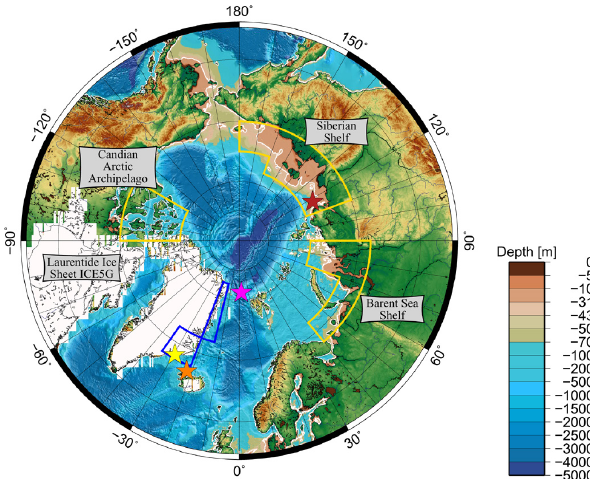
Fig. 1. Topographic map showing modern day bathymetry (National Geophysical Data Center, 2001) in the Arctic and 9kaBP ICE5G ice mask from Peltier (2004). Contour level − 31 (white) is chosen to reflect lower sea-level stand for the Laptev Sea as reconstructed by Bauch et al. (2001) (their study area is indicated by a red star). Other stars show study locations referred to in the discussion: the orange star is the study area from Andrews et al. (2009), the purple star near the Fram Strait is from Müller et al. (2009) and the yellow star denotes the core location from Jennings et al. (2002). Yellow boxes indicate shelf areas and blue boxes indicate regions used in Fig. 5, north-western and south-western Nordic